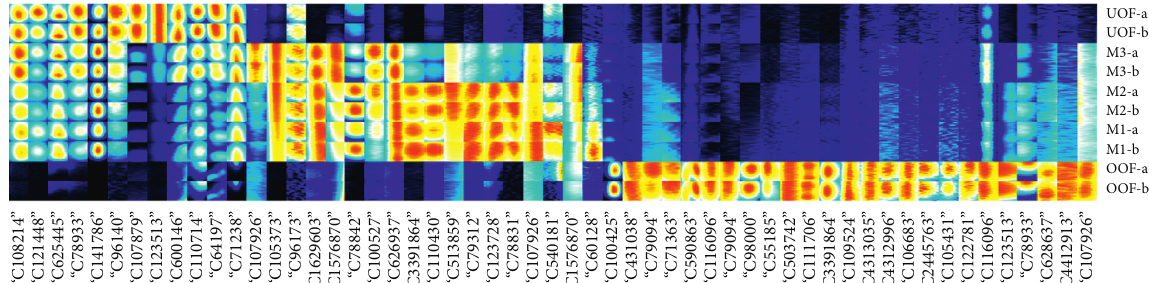
Figure 7: Volatile compound fingerprints of steamed bread made from wheat flour added with different ratios of overozonized wheat flour. a and b indicate two repetitions of determinations.